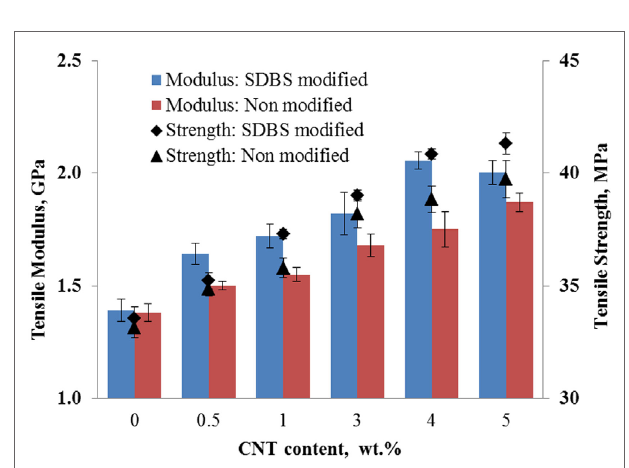
FigUre 6 | effects of cnT dispersion on the tensile properties of cnT/PP